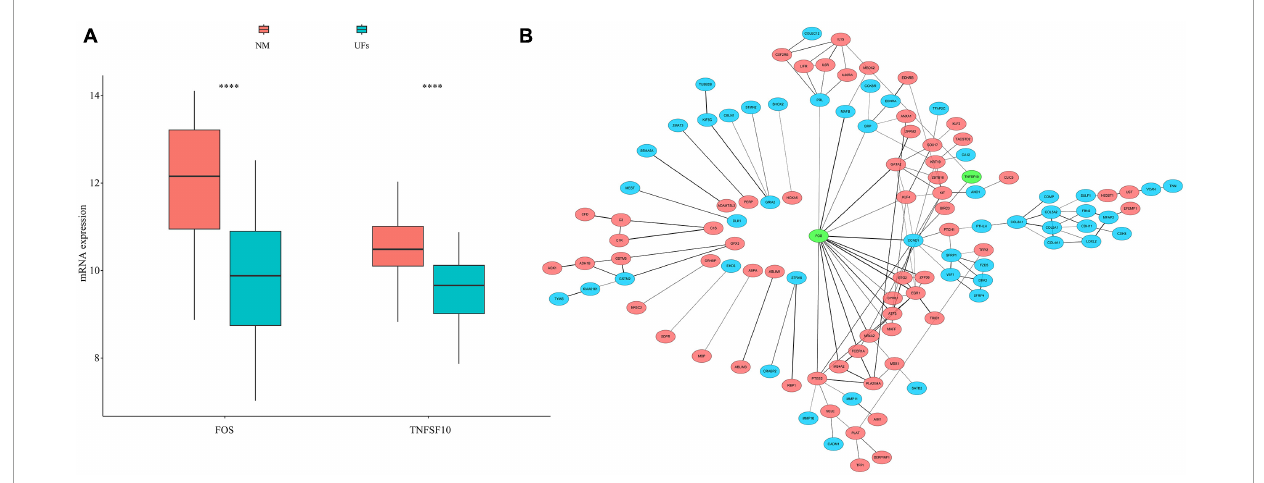
FIGURE3 Autophagy genes in methylation related genes (MRGs). (A) The expression differences of autophagy gene in MRGs. (B) PPI network of MRGs and the position of autophagy gene in the network. Red marks down-regulated MRGs, blue marks up-regulated MRGs, and green marks the location of